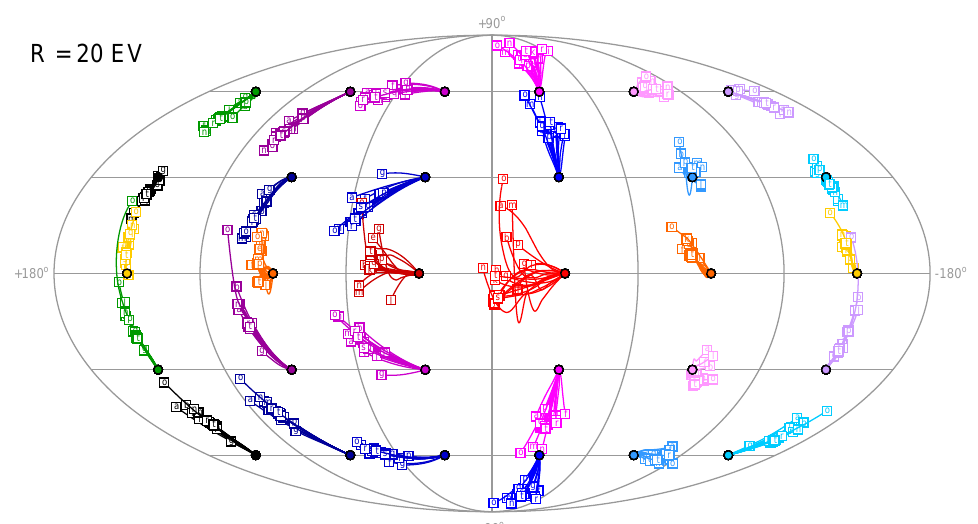
Figure 4. Backtracking of charged particles through the Galaxy starting from a regular grid of initial directions (dots). The resulting directions outside of the Galaxy for particles with a rigidity of 20 EV are denoted by squares and the lines connecting the initial and final positions were constructed by performing backtracking at higher rigidities. Each of the letters (a)-(t) denotes a di ff erent GMF model that describes the synchrotron and RM data.